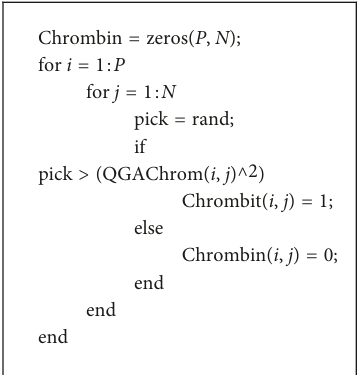
Figure 2: Conversion of the quantum bit code to the binary